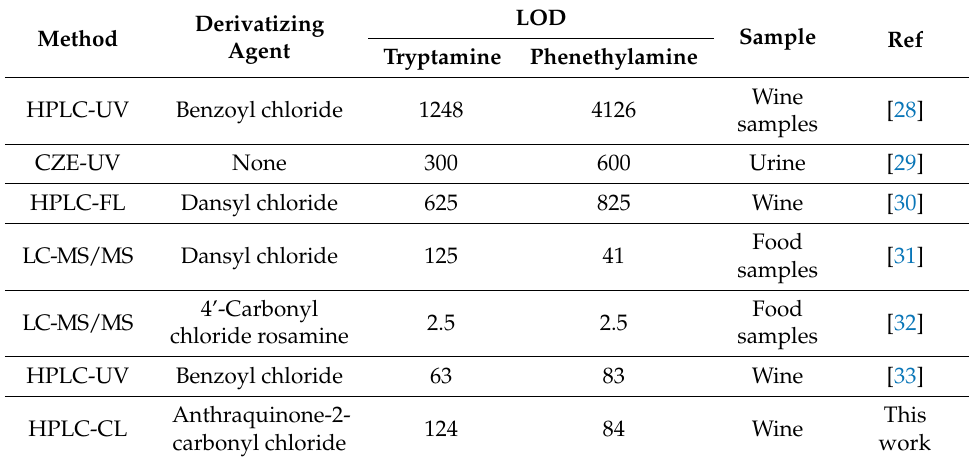
Table 2. Calibration curve and LOD of anthraquinone-tagged amine.